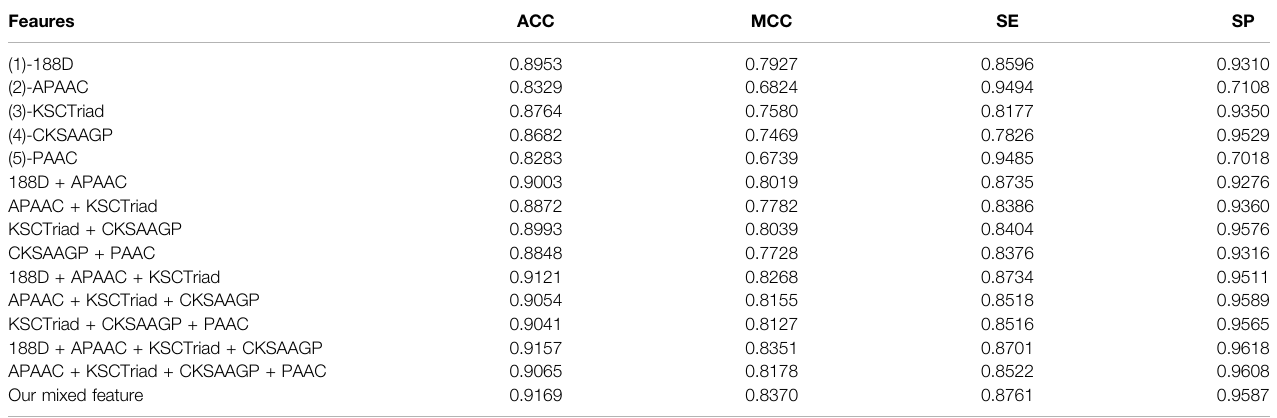
TABLE1 | Result of different features on Train-10790. Feaures